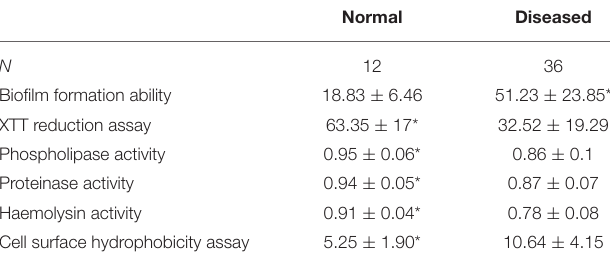
TABLE 1 | Biofilm formation ability, XTT reduction assay and phospholipase, proteinase, and hemolysin activities, and cell surface hydrophobicity assay in the samples collected from milk, female genitalia, and male genitalia of normal and diseased animals (Mean ± Standard